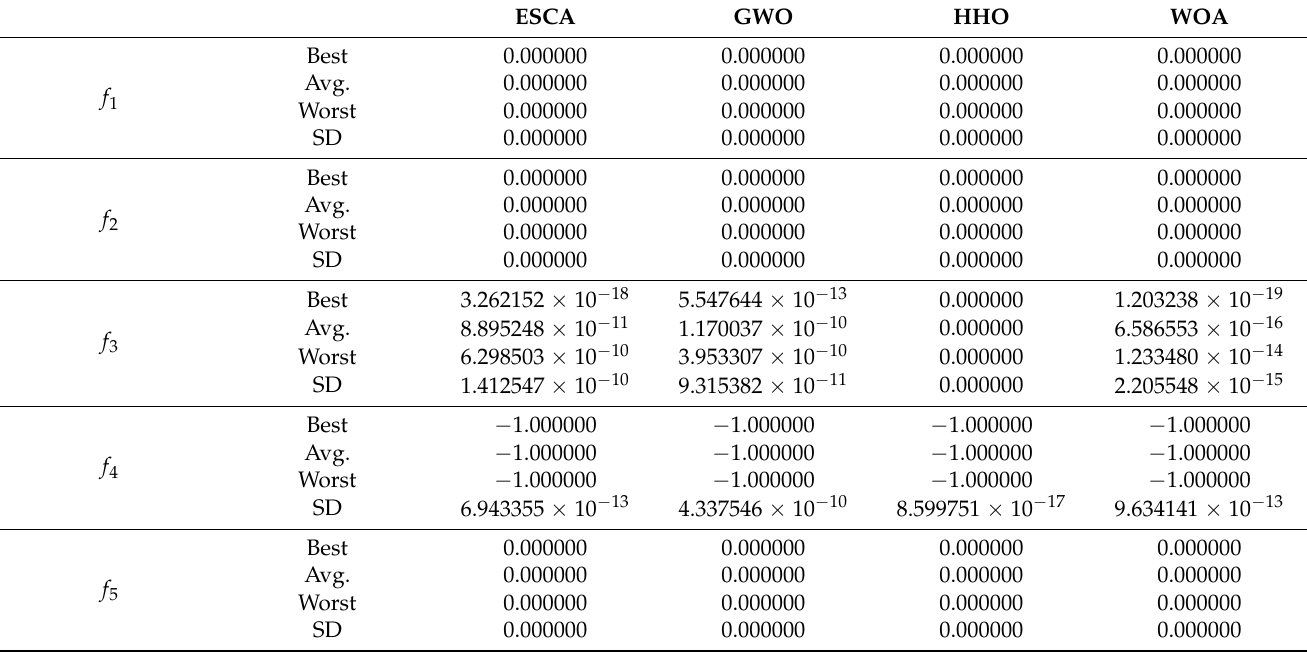
Table 18. Statistical data for 30 runs with a population of 120 and 10,000 iterations for f 1 to f 30 . ESCA GWO HHO